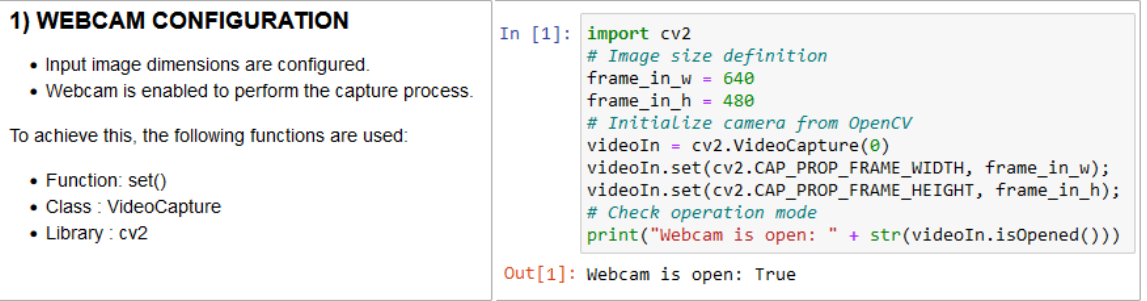
Figure 9. Example of markdown and code-cell types used for documentation and coding,